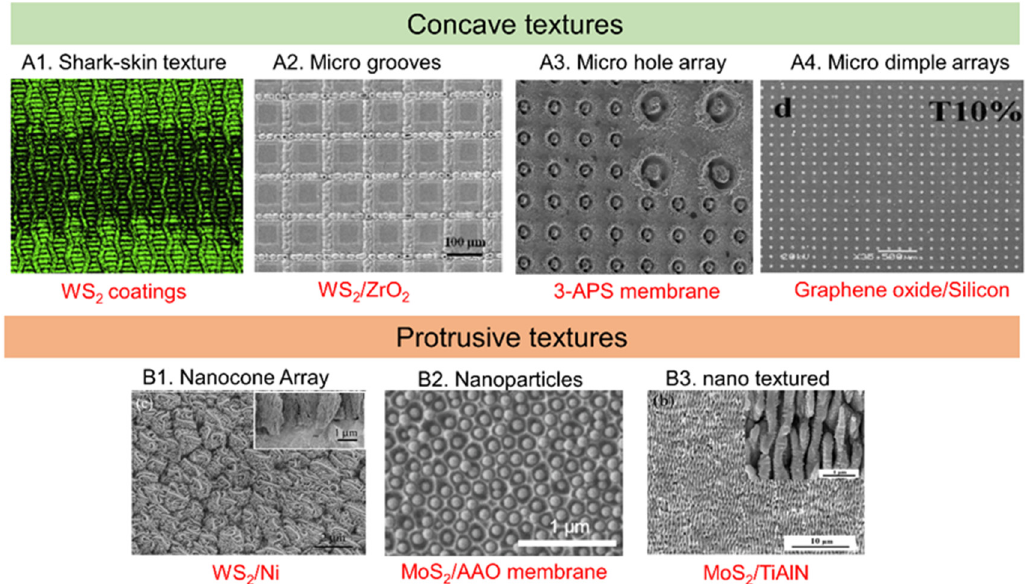
Figure 13. Different types of micro/nano textured surface used with 2D materials for reducing friction coefficients and wear. ( A1 ) Shark-skin texture [132]; ( A2 ) Linear micro grooves with WS 2 coatings [133]; ( A3 ) Micro hole array with 3-APS membranes [134]; ( A4 ) Micro dimple arrays of silicon with graphene oxide film on top [135]; ( B1 ) Nanocone array of nickel with WS 2 film [136]; ( B2 ) Nanoparticles embedded in AAO membranes with MoS 2 films [137]; ( B3 ) Nano textured TiAlN with MoS 2 coating [138].